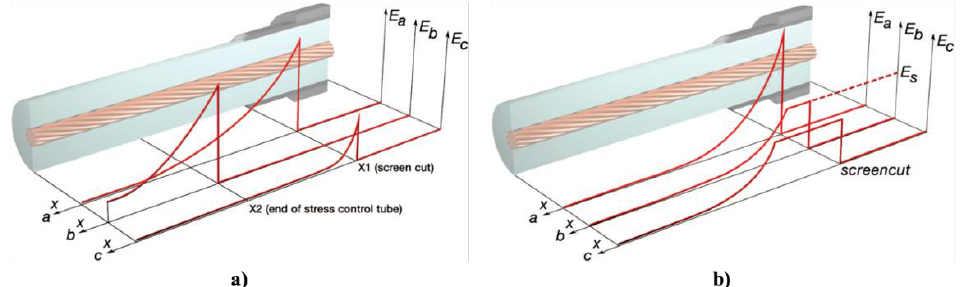
Figure 4. Electric stress distribution as a function of the position between the ground and HV electrodes ( a ) with impedance stress control and ( b ) nonlinear stress control. © 2021 IEEE. Reprinted, with permission, from [22].